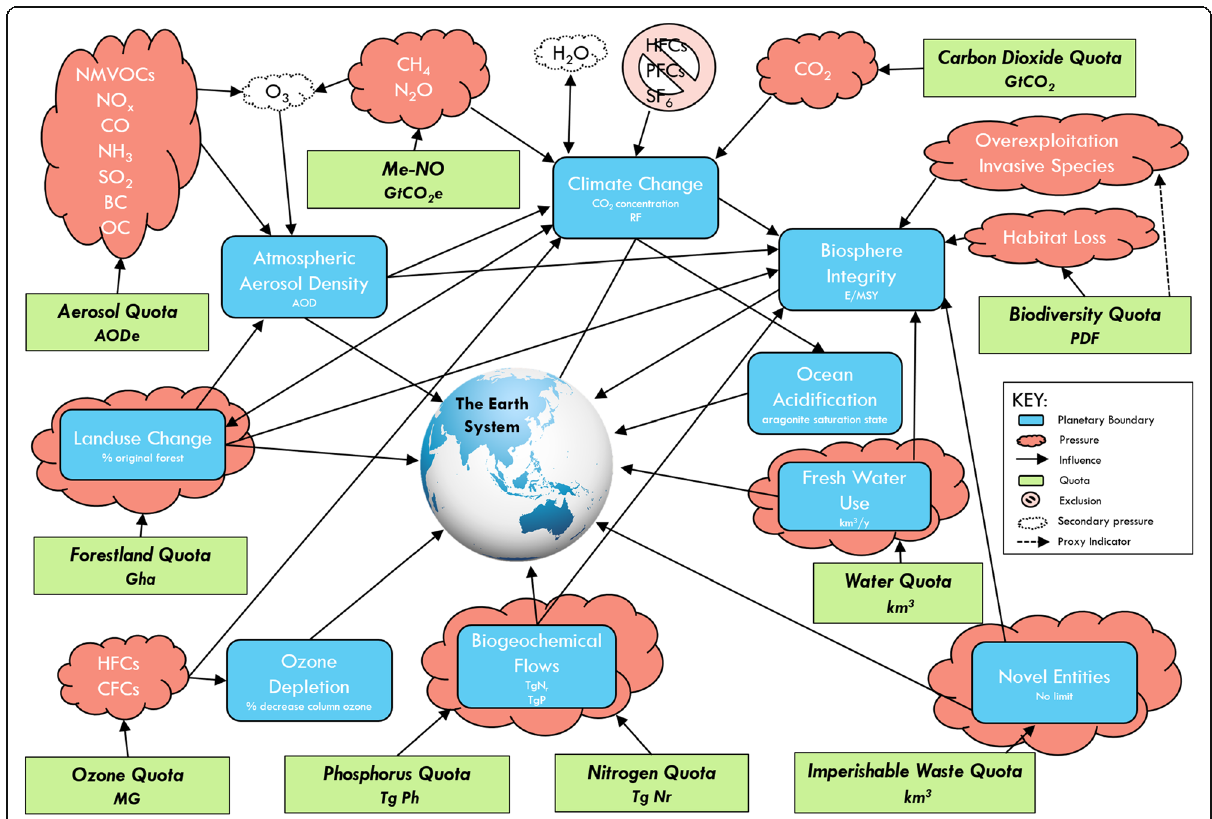
Fig. 5 Translating Planetary Boundaries to Critical Pressures and then to Planetary